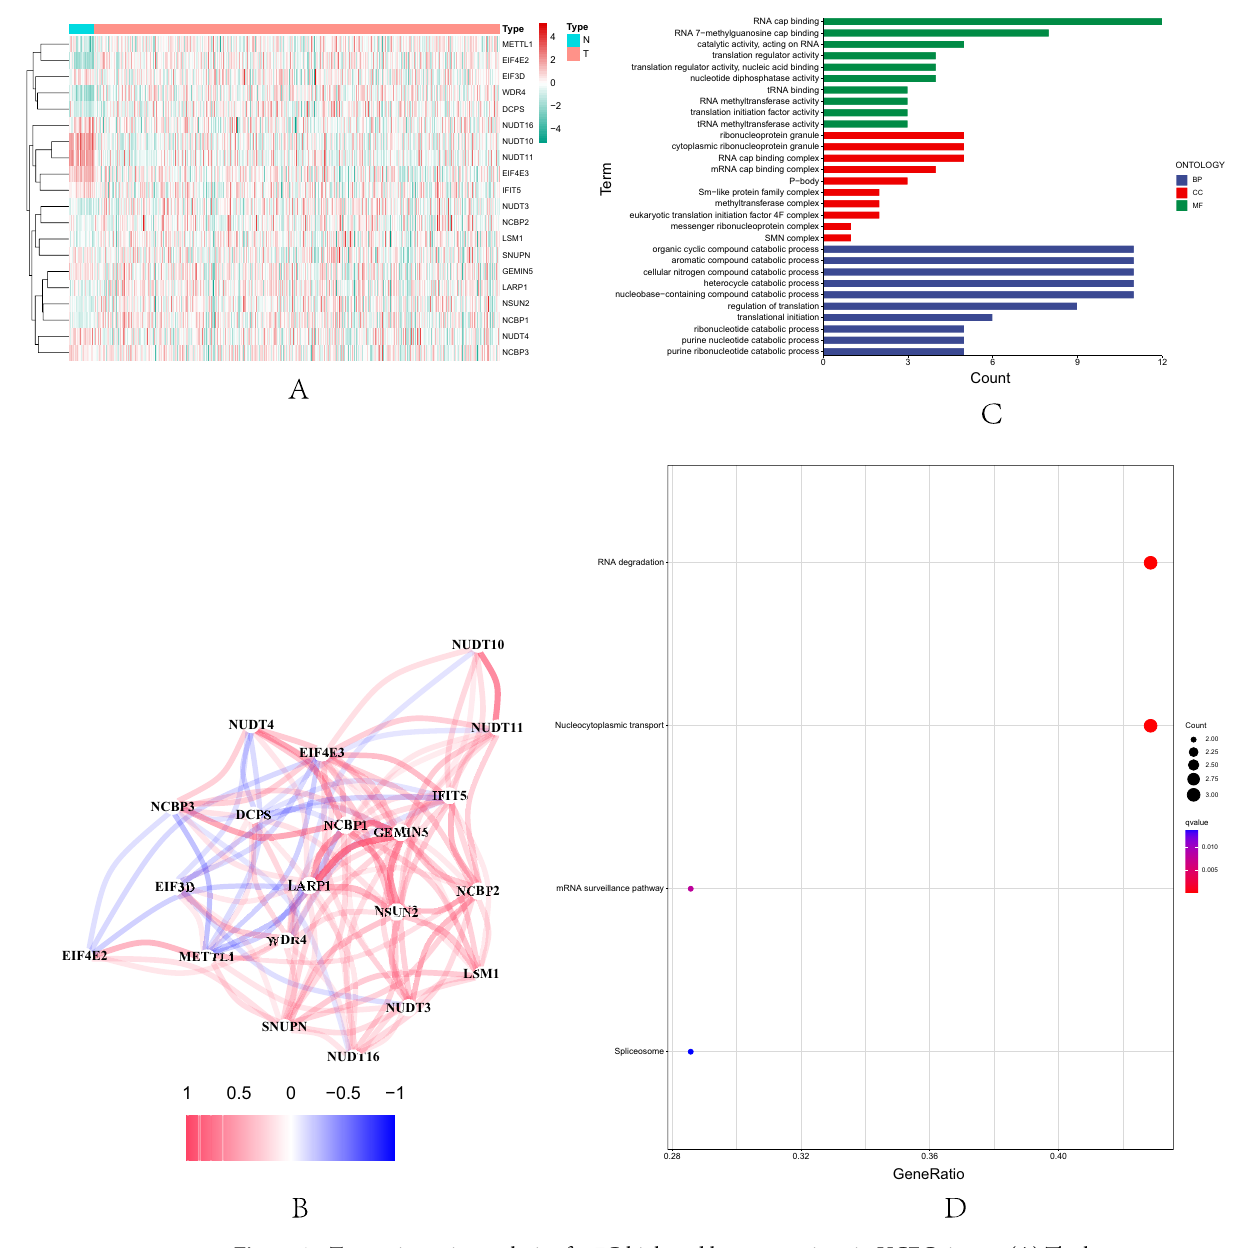
Figure 1. Transcriptomics analysis of m7G high and low expressions in UCEC tissues. ( A ) The heat map shows 20 DEGs. ( B ) Correlation network diagram of DEGs. ( C ) GO enrichment analysis results. ( D ) KEGG enrichment analysis